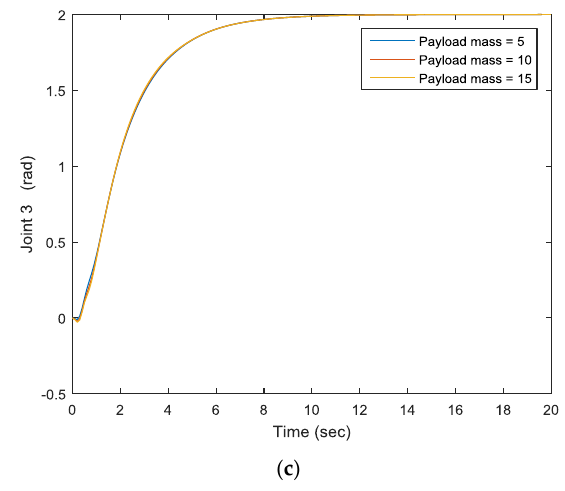
Figure 8. The output of joint 1 ( a ), joint 2 ( b ) and joint 3 ( c ).